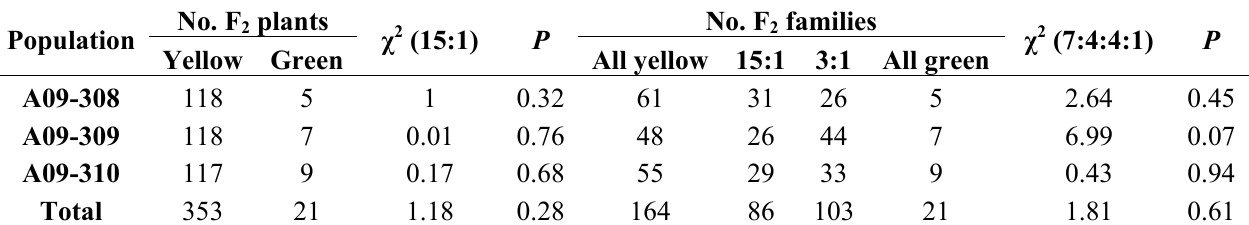
Table 2. F and F segregation patterns for cotyledon color, Chi-square and P -values 2 2:3